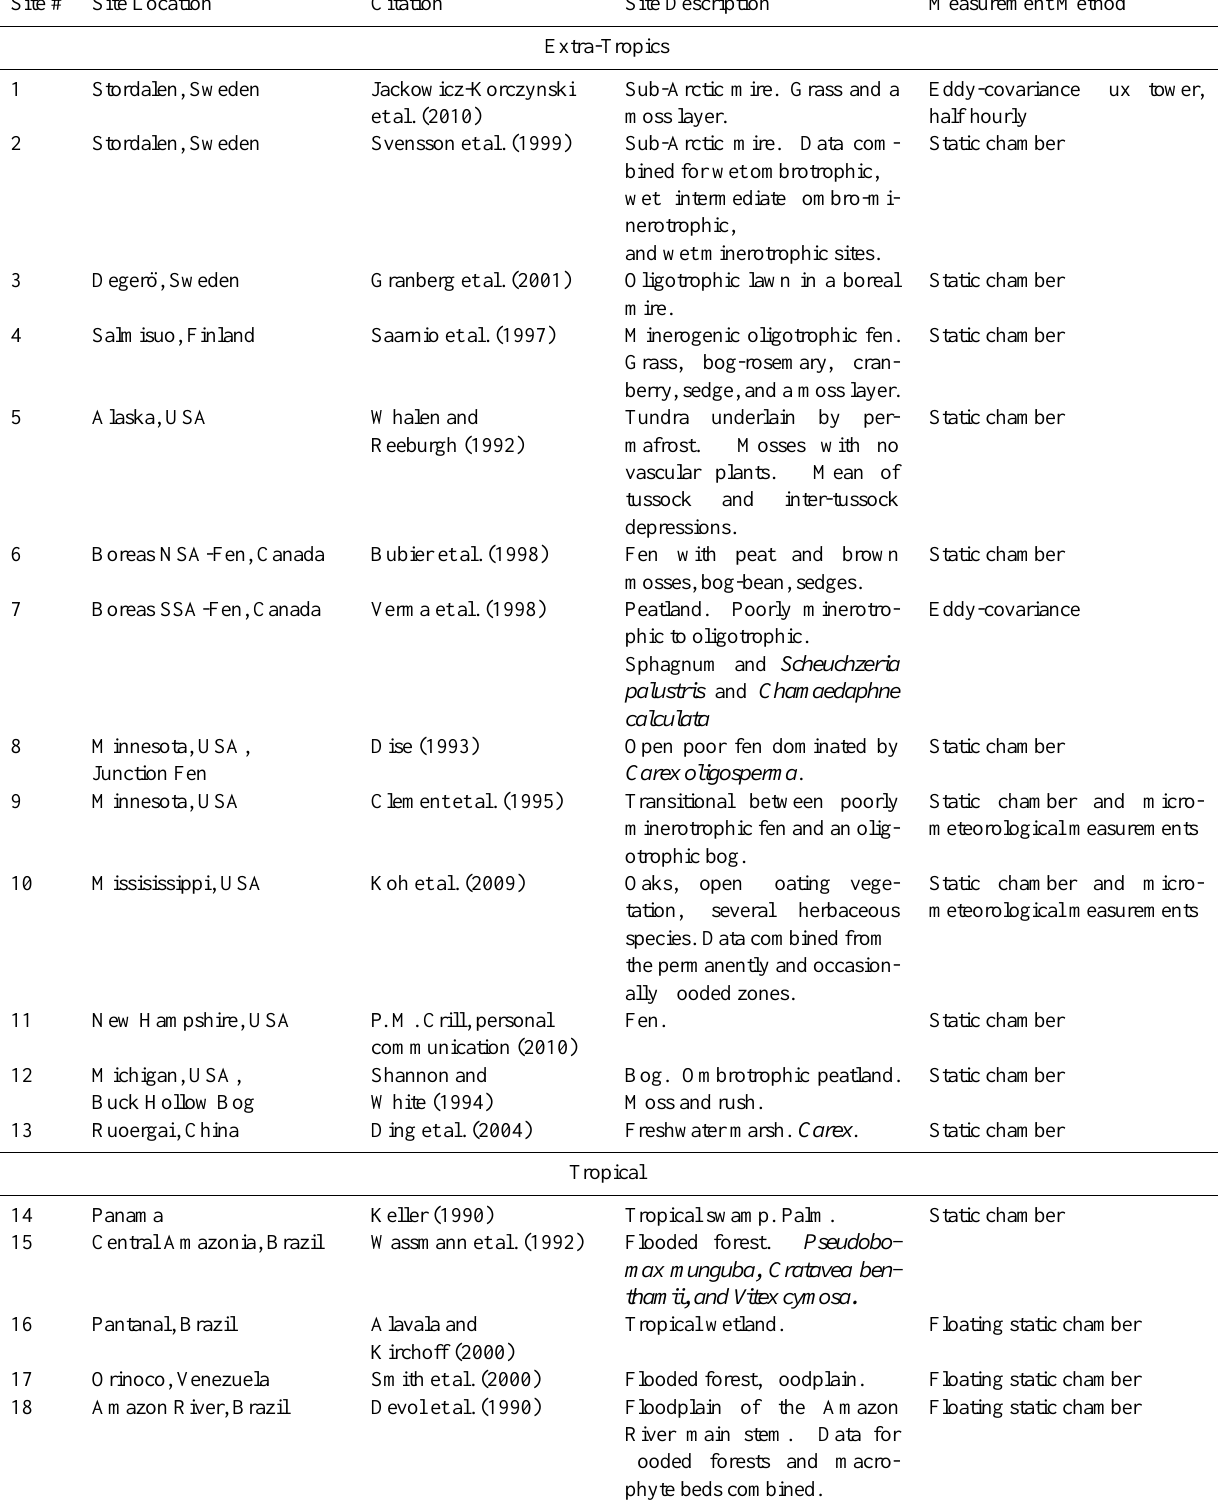
Table 3. Description of the sites and measurements used in the comparison with model